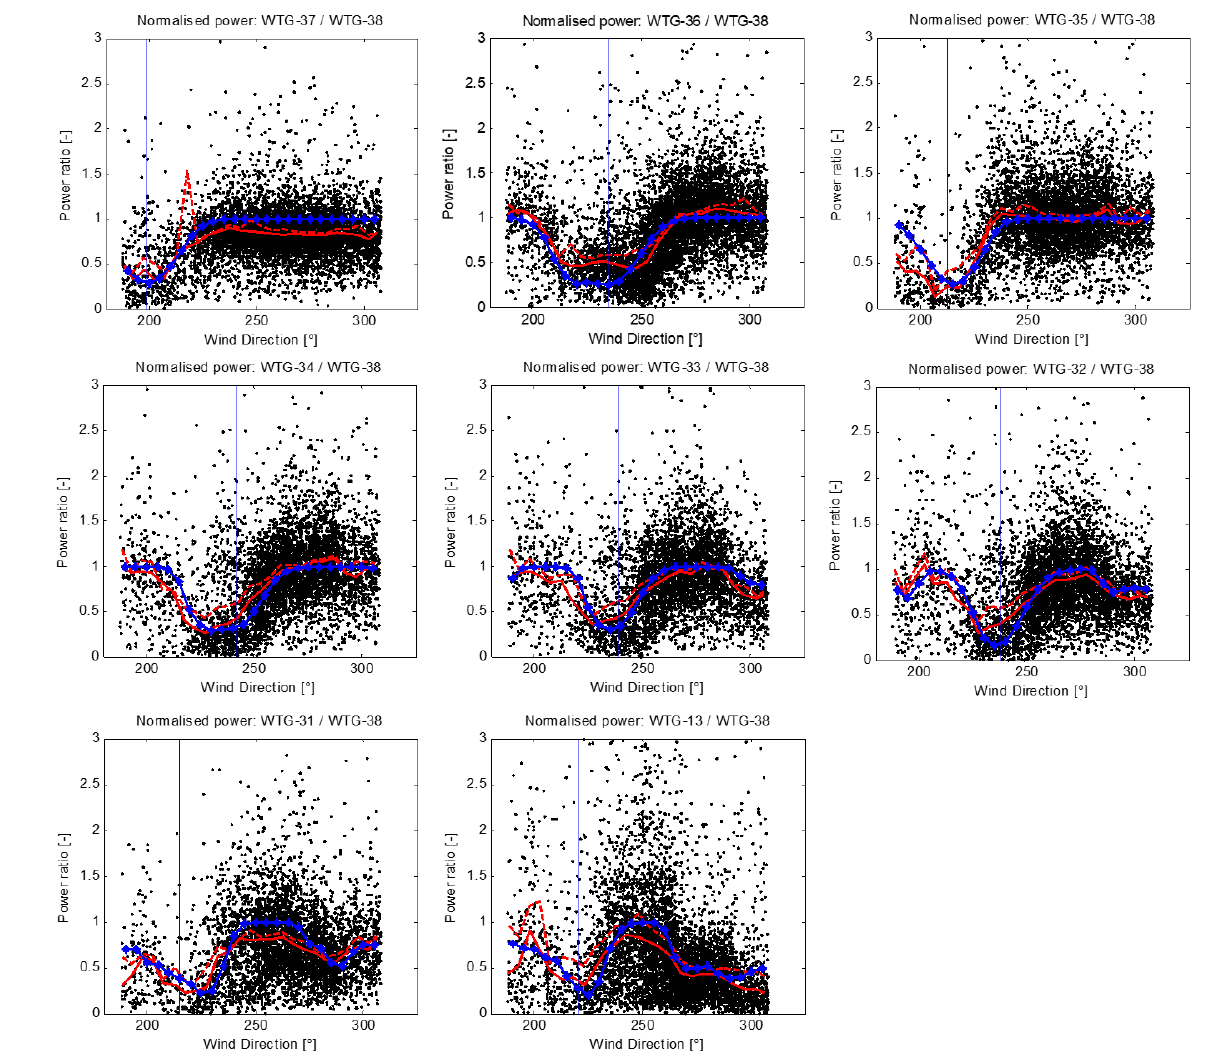
Figure 5. Selected model (blue) compared to SCADA data (black, with bin means shown by dashed red lines and medians by solid red lines). The vertical blue line shows the direction of the turbine just